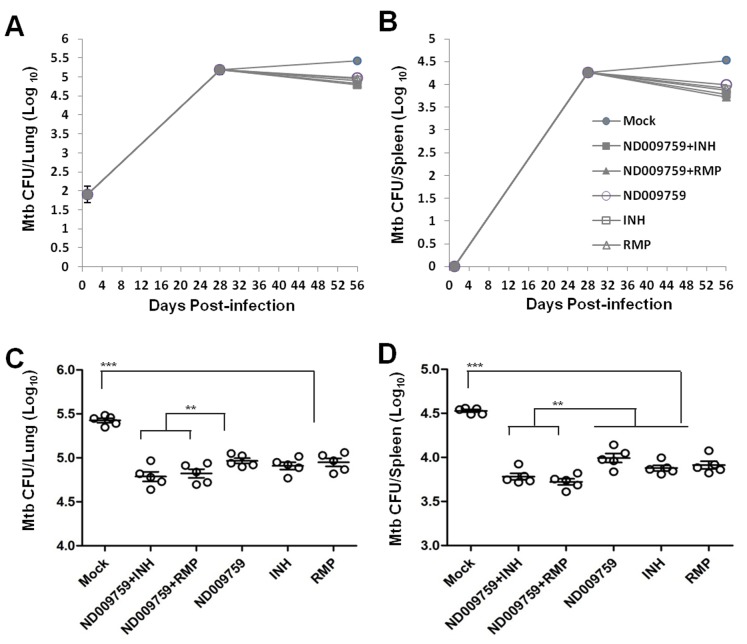
Mycobacterial counts in the lungs and spleens of M. tuberculosis-infected Balb/c mice after treatment with ND-09759 or combination regimens.Balb/c mice (n = 5) were infected with M. tuberculosis H37Rv by aerosol challenge and then treated by oral gavage with 80% aqueous propylene glycol (solid cycle, vehicle control), ND-09759 (cycle), ND-09759 plus INH (solid square), ND-09759 plus RMP (solid triangle), INH (square) and RMP (triangle), respectively, as described in Materials and Methods. The results show the log10 CFU in the lung (A and C) and spleen (B and D). C and D, Mycobacterial counts after the completion of chemotherapy and each open cycle represents an individual mouse. ***, p<0.05 compared to no treatment group; **, P<0.05 between ND-09759 alone and ND-09759+ INH or RMP.